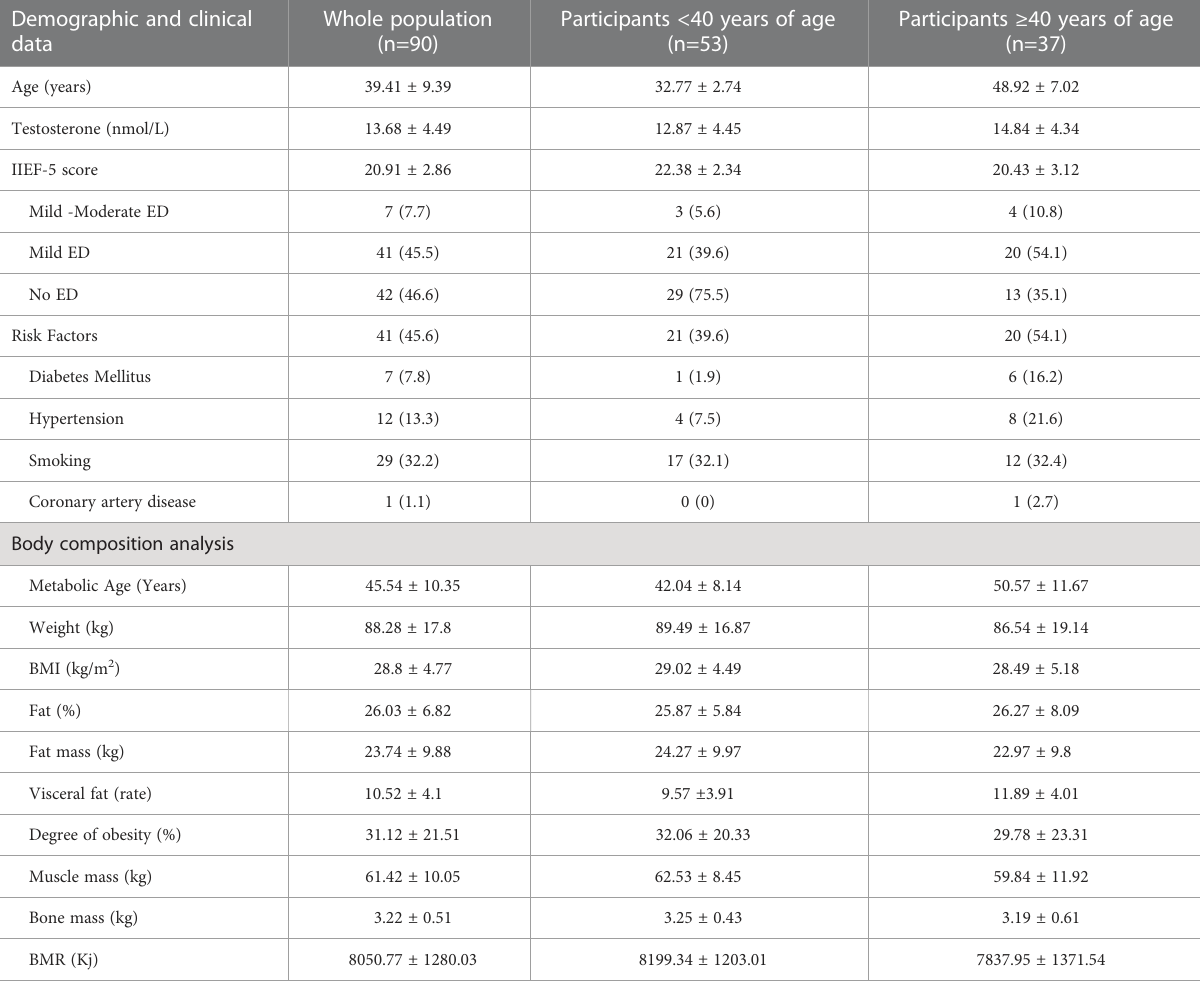
TABLE 1 Characteristics of the study population: whole population, participants < and ≥ 40 years of